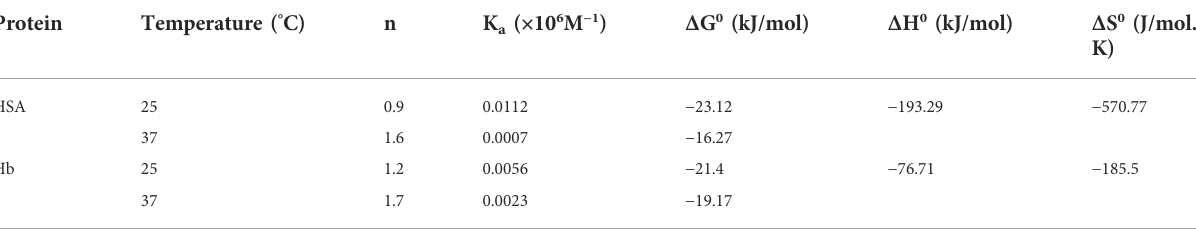
TABLE 2 Binding and thermodynamic parameters for the hydrogel interaction with the model proteins. Protein